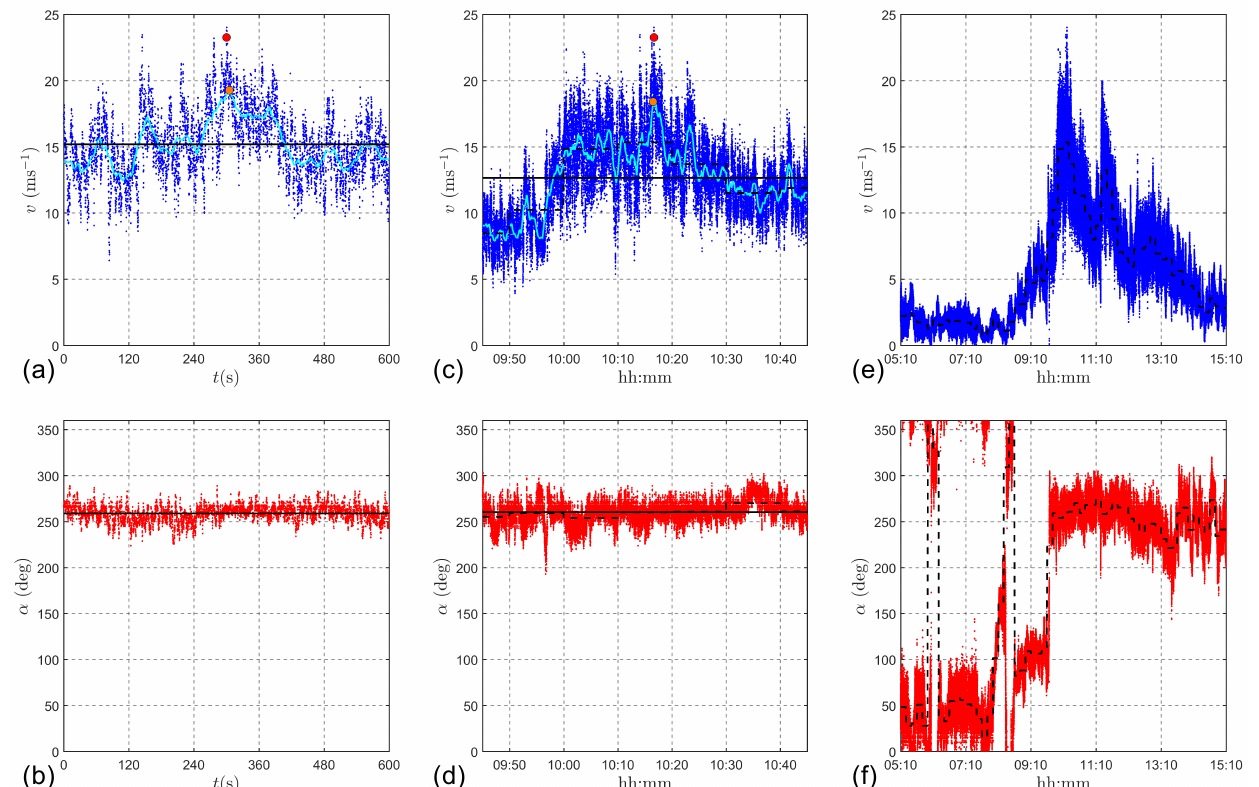
Figure 10. Thunderstorm outflow recorded on 21 November 2013 at about 10:15UTC by the anemometer 2 of the port of Genoa: wind speed time-series in 10min (a) , 1h (c) , and 10h (e) ; wind direction time-series in 10min (b) , 1h (d) , and 10h (f)